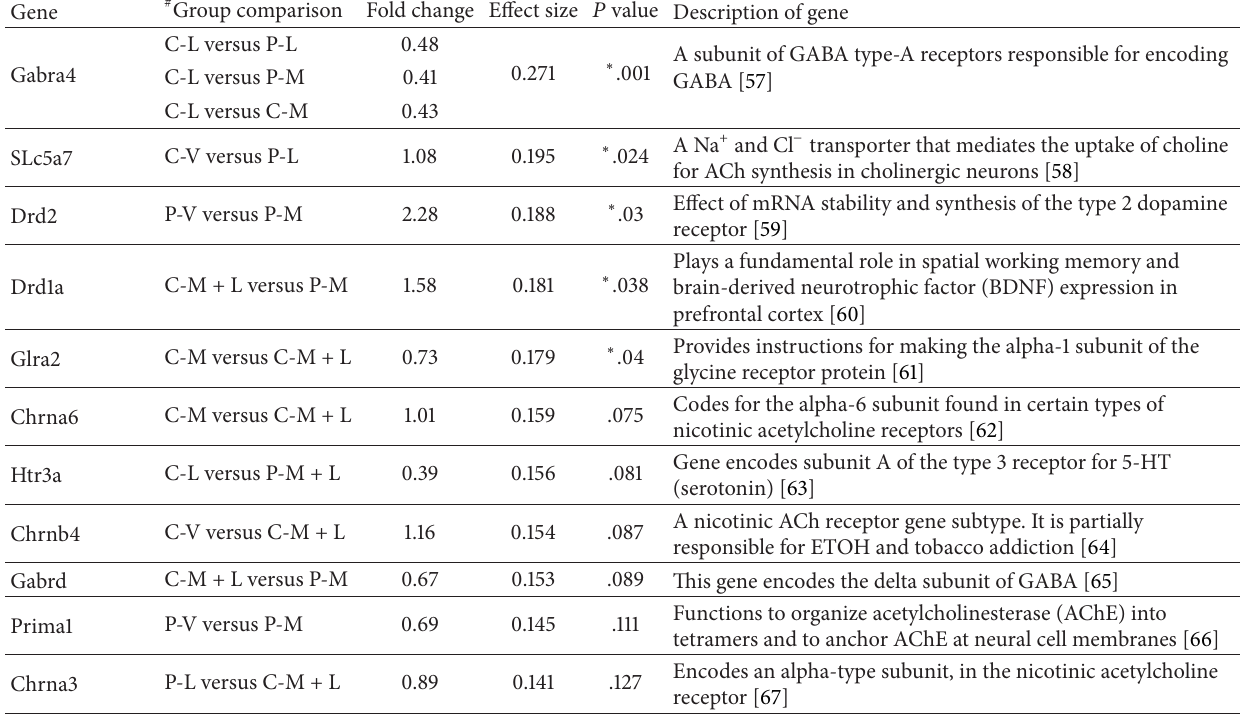
Table 3: Between-group changes in gene expression within the